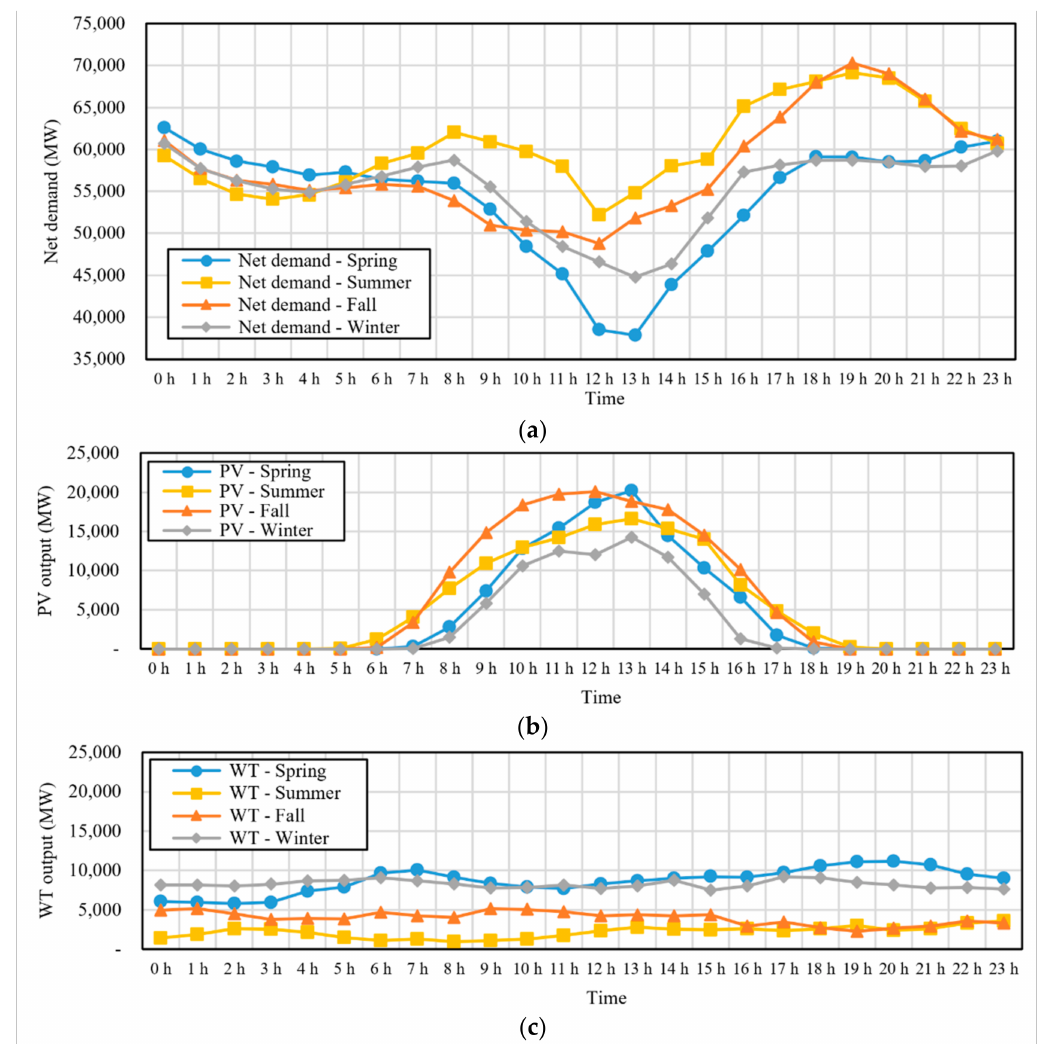
Figure 3. Power patterns for the selected day by season: ( a ) net demand, ( b ) PV output, and ( c ) WT